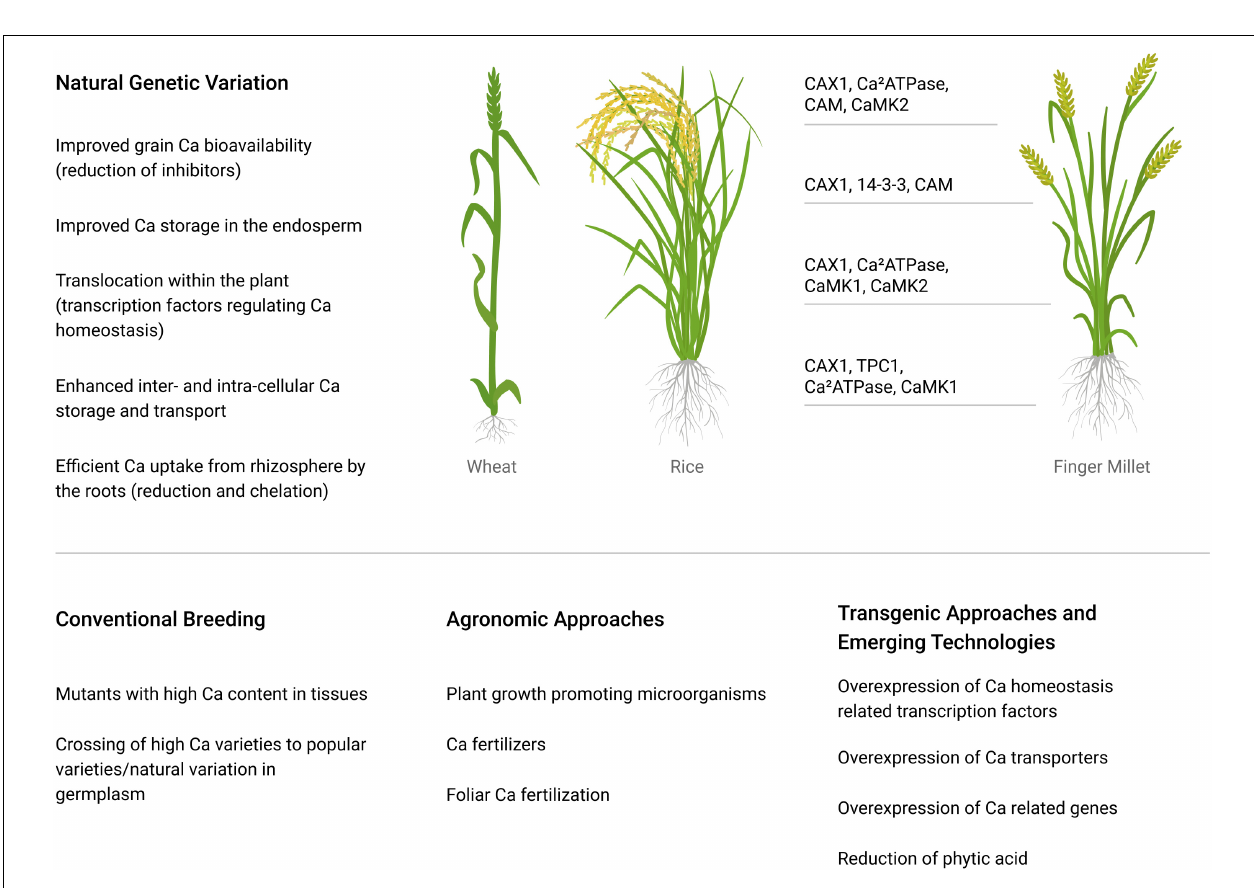
FIGURE 2 | Potential mechanisms to improve Ca content of major crops. The transporters in finger millet have been studied more extensively, and they are presented lining up to the regions of the plant to where they appear to be expressed; data taken from Mirza et al. (2014) and Puranik et al.